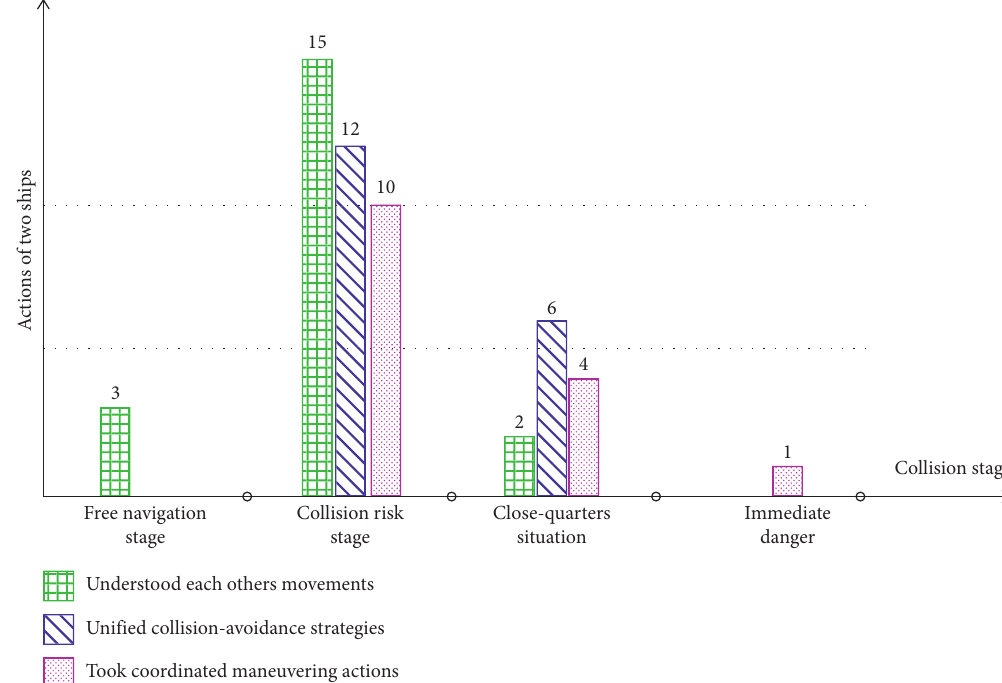
Figure 2: Distribution of observed coordinated collision-avoidance actions that two ships typically take in an inland waterway.